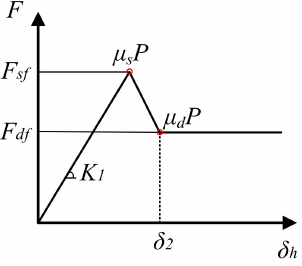
Figure 11. Constitutive model of